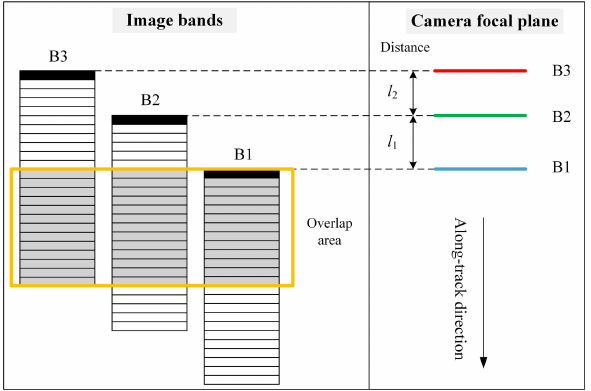
Figure 2. Image bands and camera focal plane Image matching is employed on corresponding lines between adjacent bands, and correlation coefficient is used for coarse matching, least squares algorithm is utilized for fine matching. First, the initial corresponding point is obtained in the neighborhood of the initial image point. The